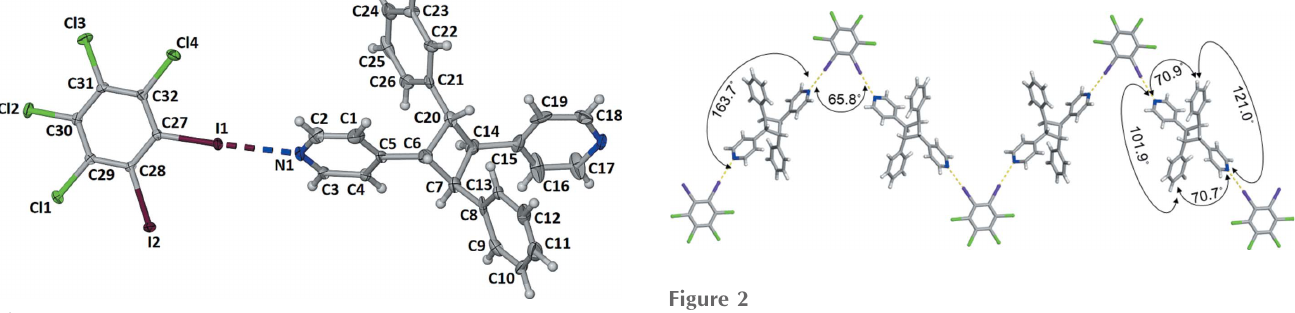
Figure 1 The labelled asymmetric unit of ( 1,2-C 6 I 2 Cl 4 ) (cid:2) ( ht -PP ). Displacement ellipsoids are drawn at the 50% probability level for non-hydrogen atoms while hydrogen atoms are shown as spheres of arbitrary size.